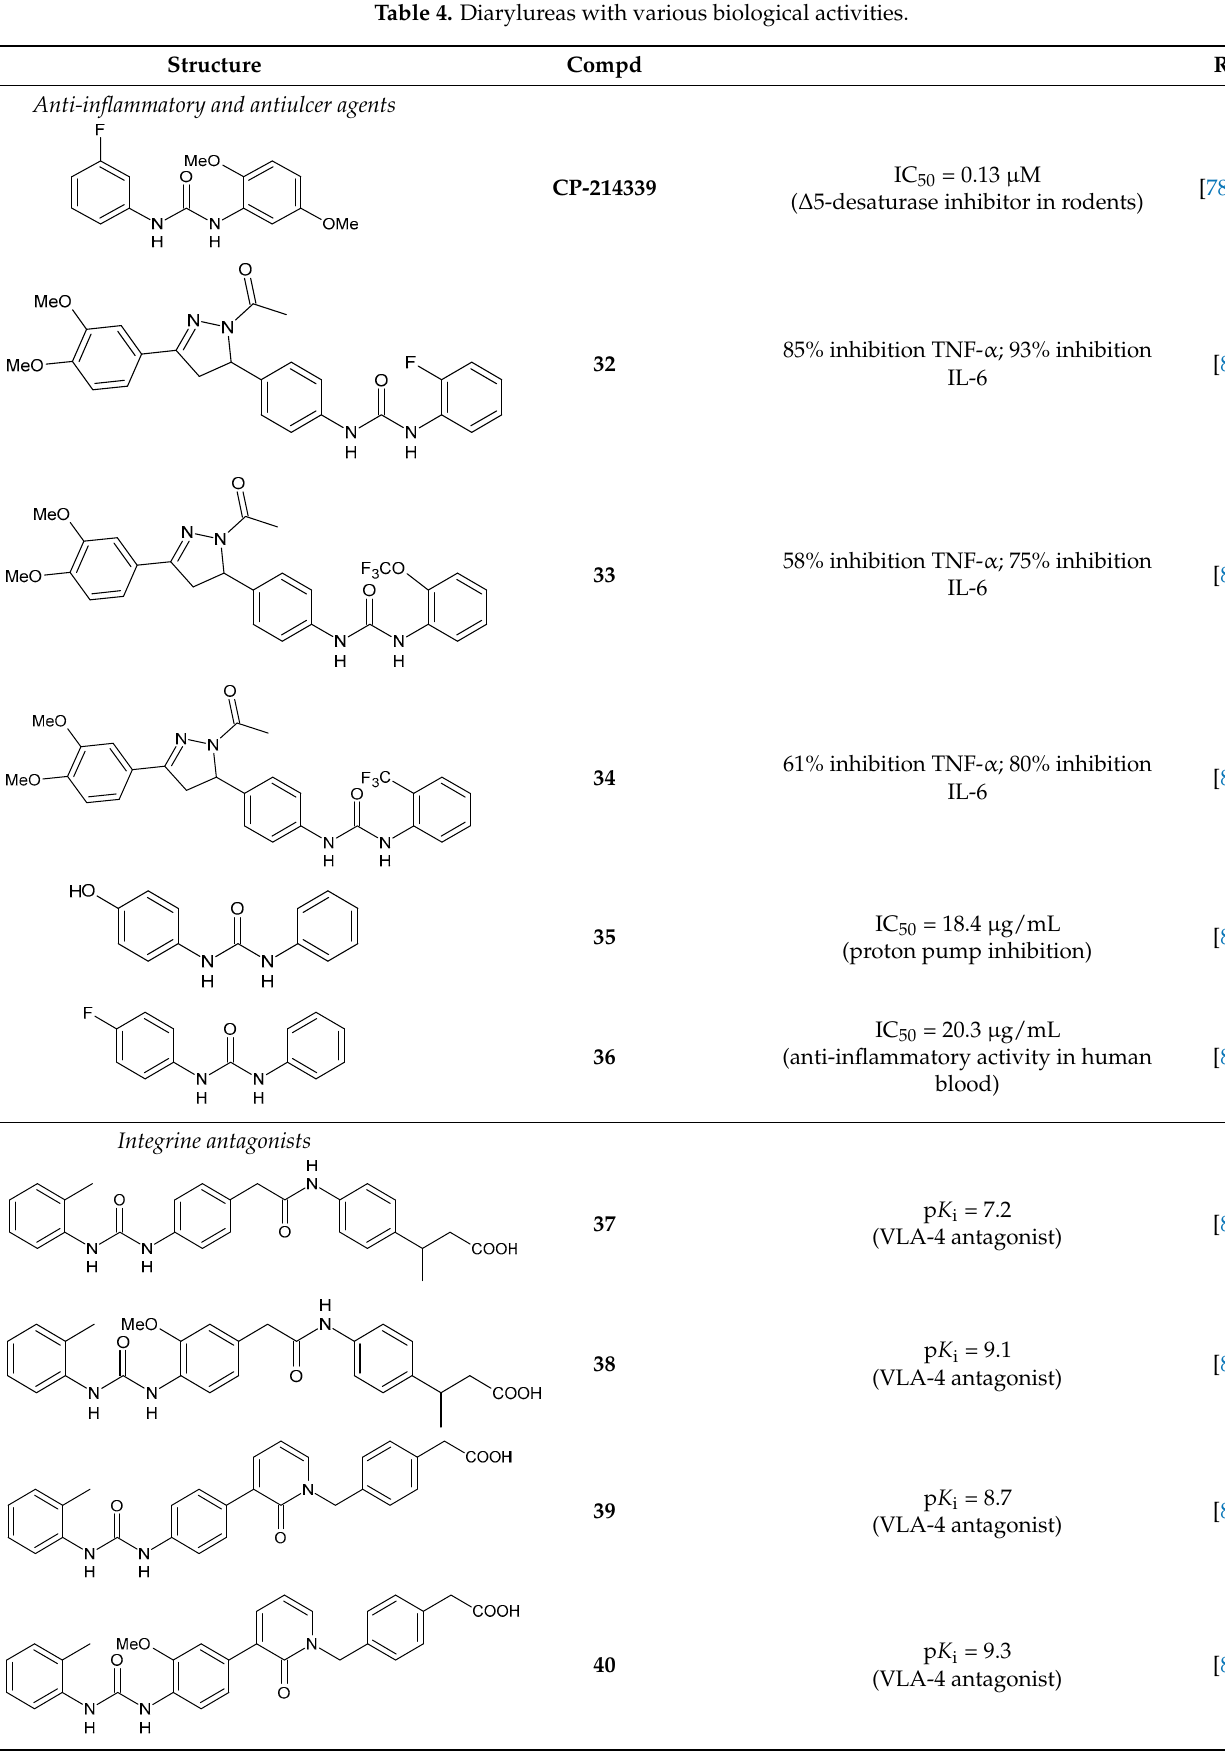
Table 4. Diarylureas with various biological activities.